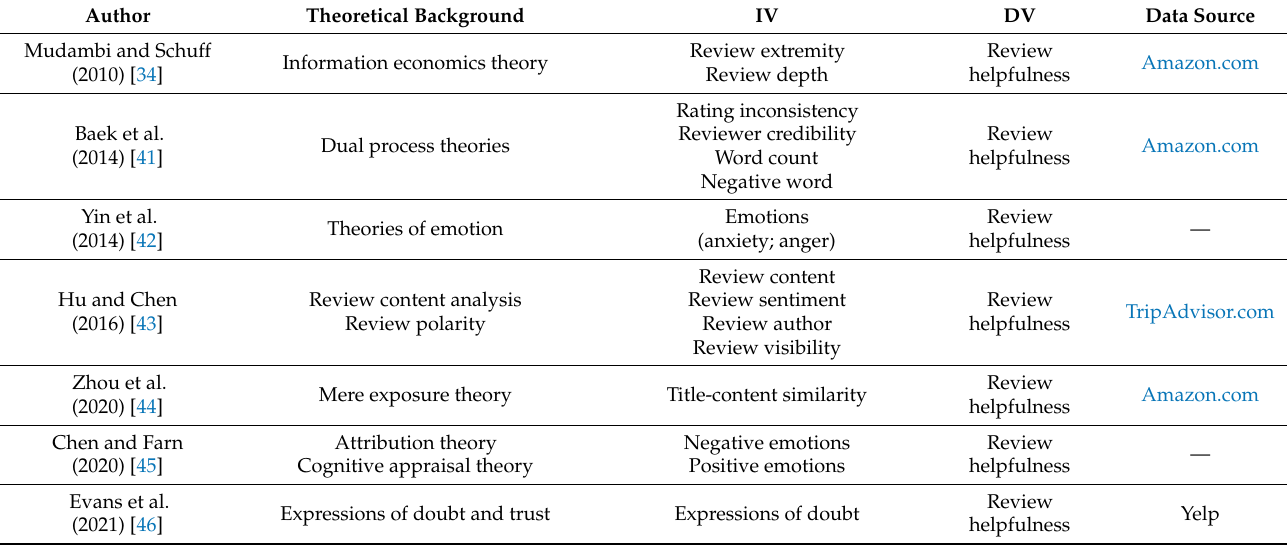
Table 1. Literature review on the usefulness of